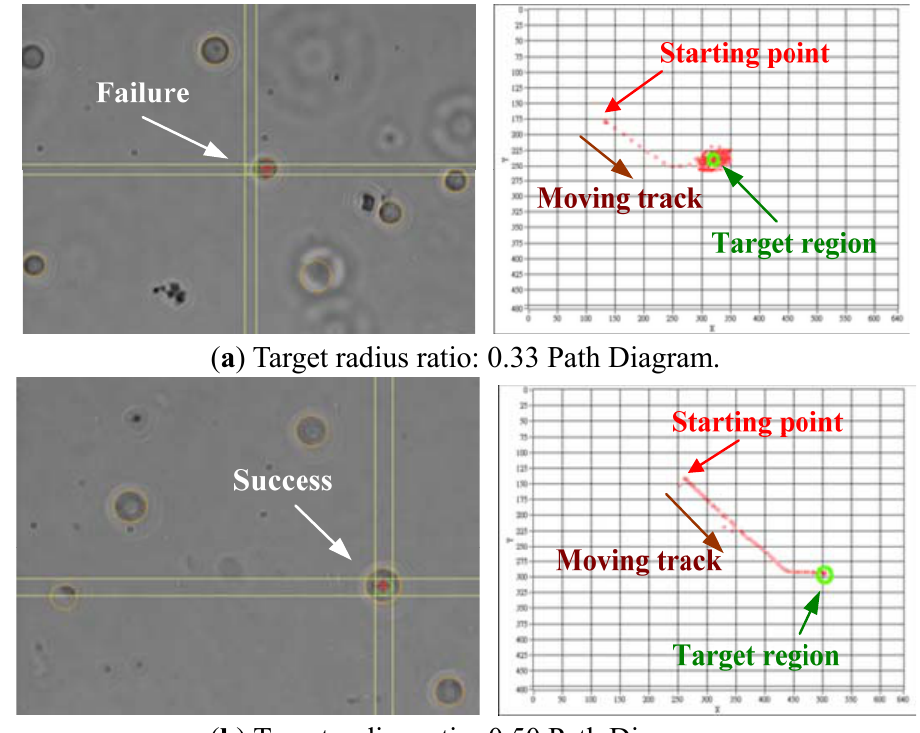
Figure 12. ( a ) A real failure diagram as the target radius ratio is too small; ( b ) A real successful diagram as the target radius ratio is appropriate.